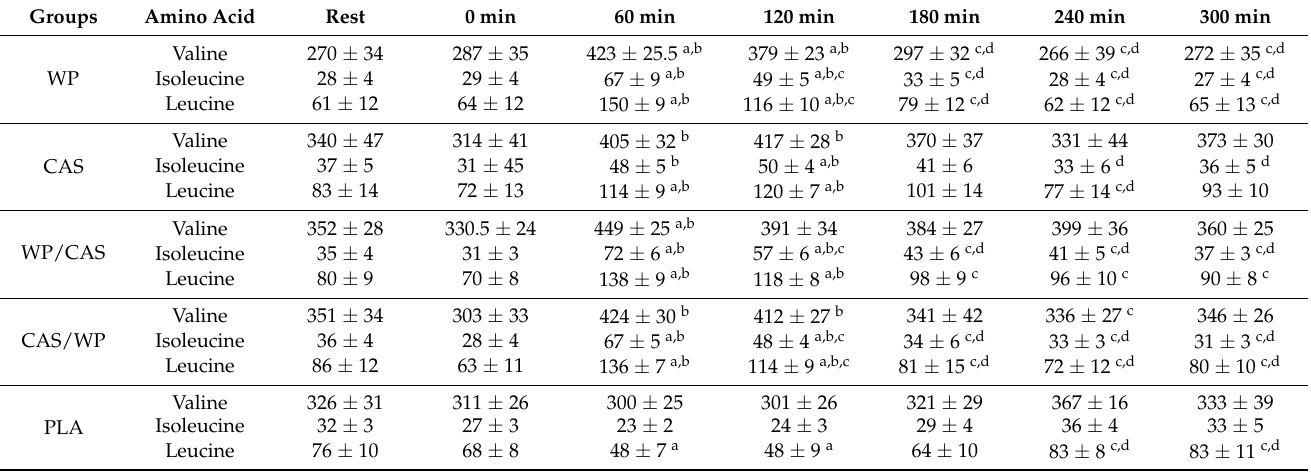
Table 2. Branched-chain amino acid concentration ( µ mol/L), differences between the supplements and time points. Groups Amino